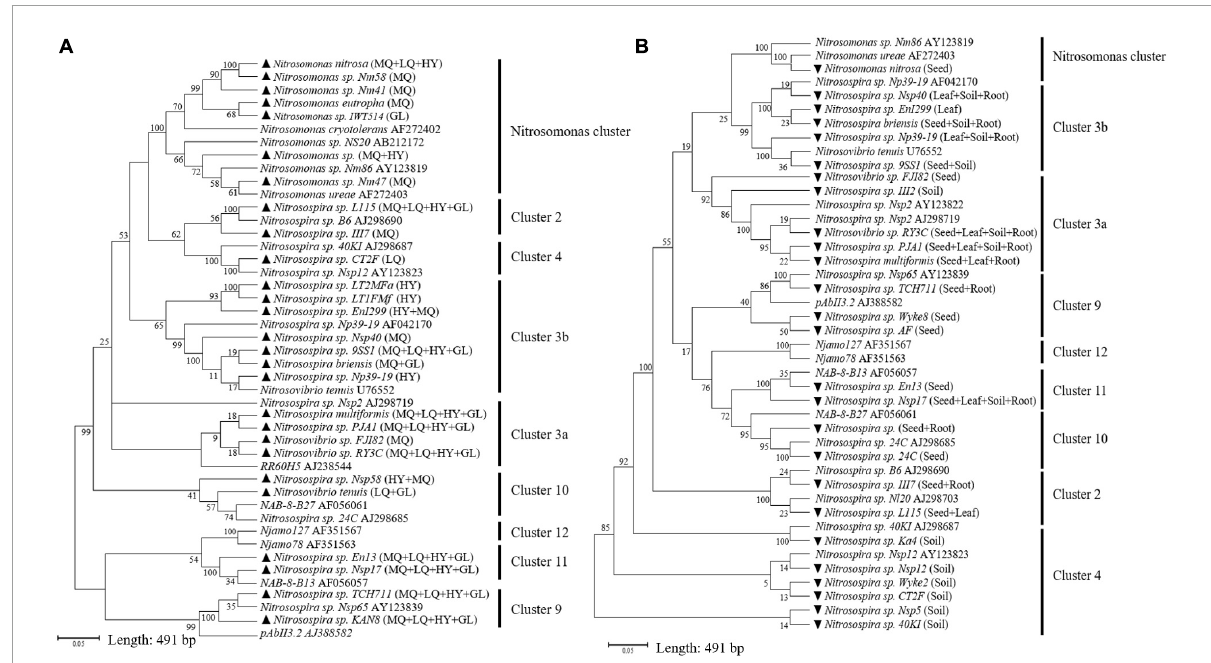
FIGURE1 Neighbor-joining tree constructed with OTUs consisting of 491 bp fragment of the amoA sequences retrieved from E. nutans seeds at four locations (A) and different plant parts of E. nutans growing in alpine meadows at Maqu Azi station (B) . Filled black triangles in panel (A) represent AOB species in E. nutans seeds at the four locations and the capital letters in parentheses represent different sampling sites (MQ = Maqu; LQ = Luqu; HY = Hongyuan; GL = Guoluo). Filled black inverted triangles in panel (B) represent AOB species from different plant parts of E. nutans at Maqu Azi station. The reference sequences for AOB clusters are from Boyle-Yarwood et al. (2008) and Chen et al.